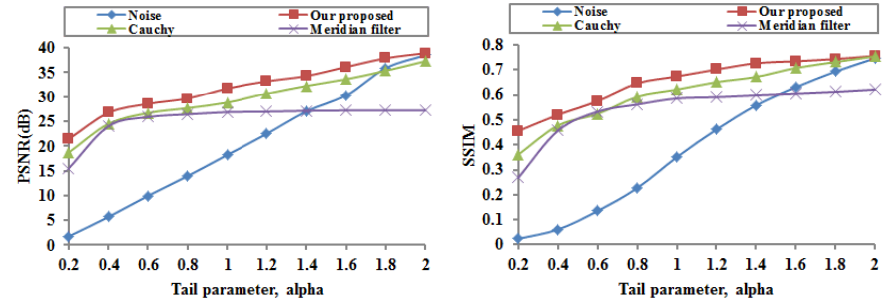
Figure 3. Performances of the noisy image and the recovered images at different alpha parameters.